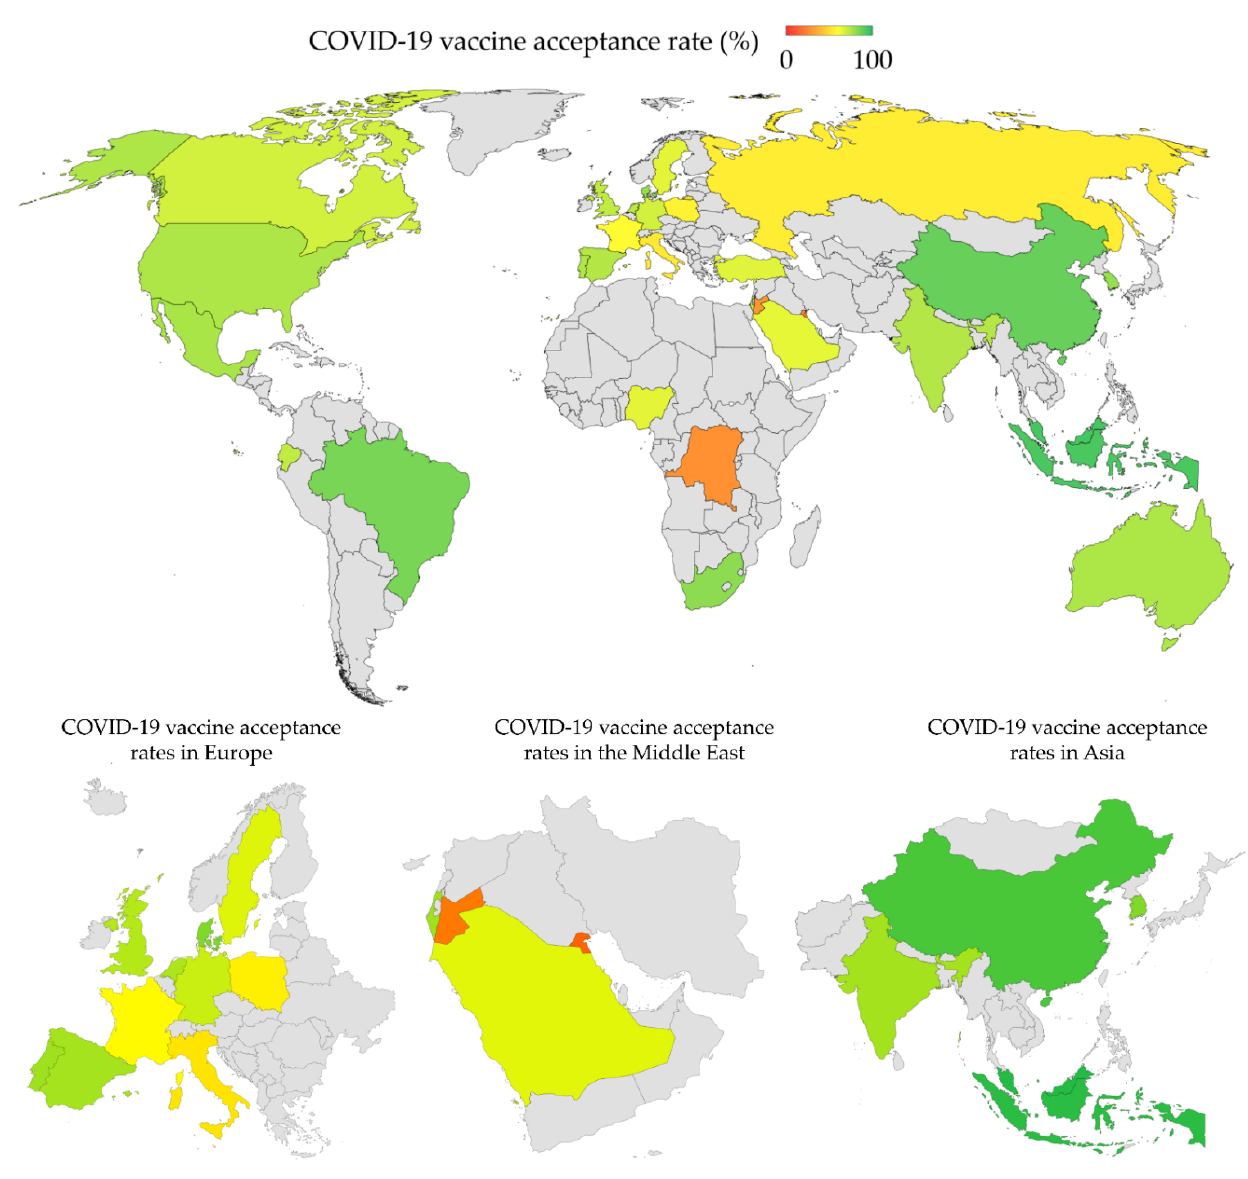
Figure 2. COVID-19 vaccine acceptance rates worldwide. For countries with more than one survey study, the vaccine acceptance rate of the latest survey was used in this graph. The estimates were also based on studies from the general population, except in the following cases where no studies from the general public were found (Australia: parents/guardians; DRC: healthcare workers; Hong Kong: healthcare workers; Malta: healthcare workers).